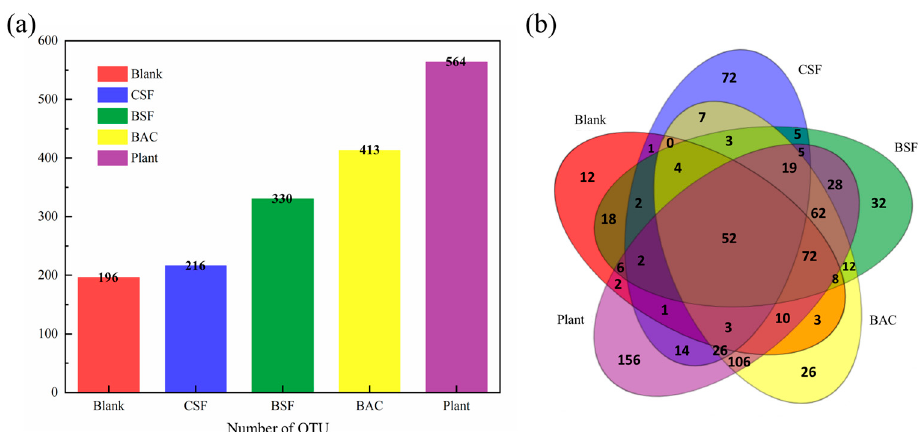
Figure 6. ( a ) Rarefaction curve; and ( b ) Shannon index curve.